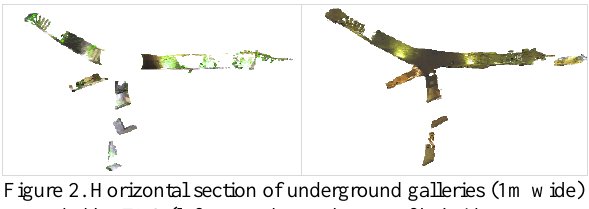
Figure 2. Horizontal section of underground galleries (1m wide) recorded by TLS (left: gaps due to the use of hybrid scanner as Trimble GX, and right: better coverage with the Leica C10 panorama scanner)